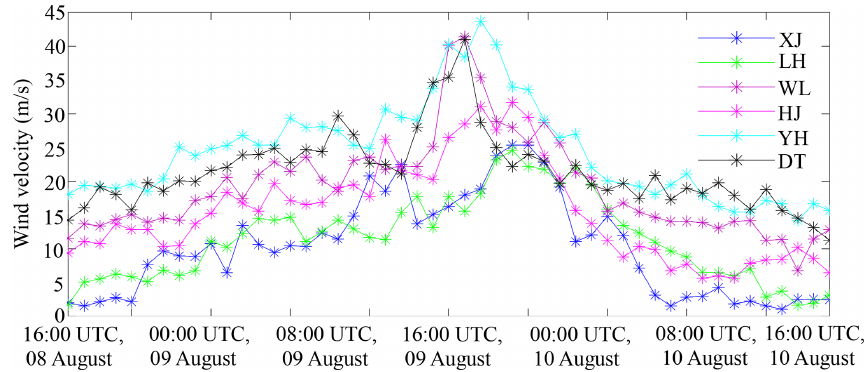
Figure 4. Time series of hourly maximum wind speed at the six national meteorological stations between 16:00UTC, 8 August 2019, and 16:00UTC, 10 August